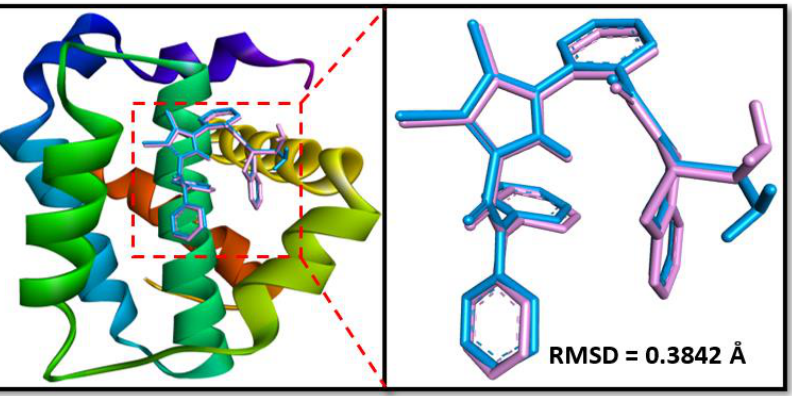
Figure 6. Validation of the docking protocol by extracting and re-docking the ligand (originally bound to the protein in the X-ray crystal structure). RMSD was calculated by superimposing the docked and crystal structure poses of the ligand. Chemically DRO is 1-(2-{[(3 S )-3-(aminomethyl)- 3,4-dihydroisoquinolin-2(1 H )-yl]carbonyl}phenyl)-4-chloro-5-methyl- N , N -diphenyl-1 H -pyrazole- 3-carboxamide.